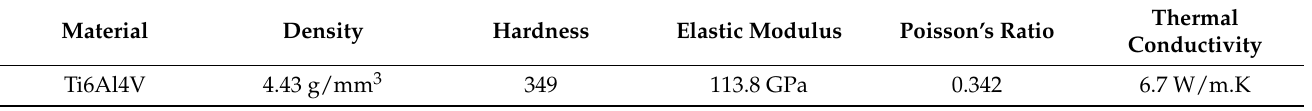
Table 2. The machining parameters of abrasive grinding and electrical discharge grinding (EDG).